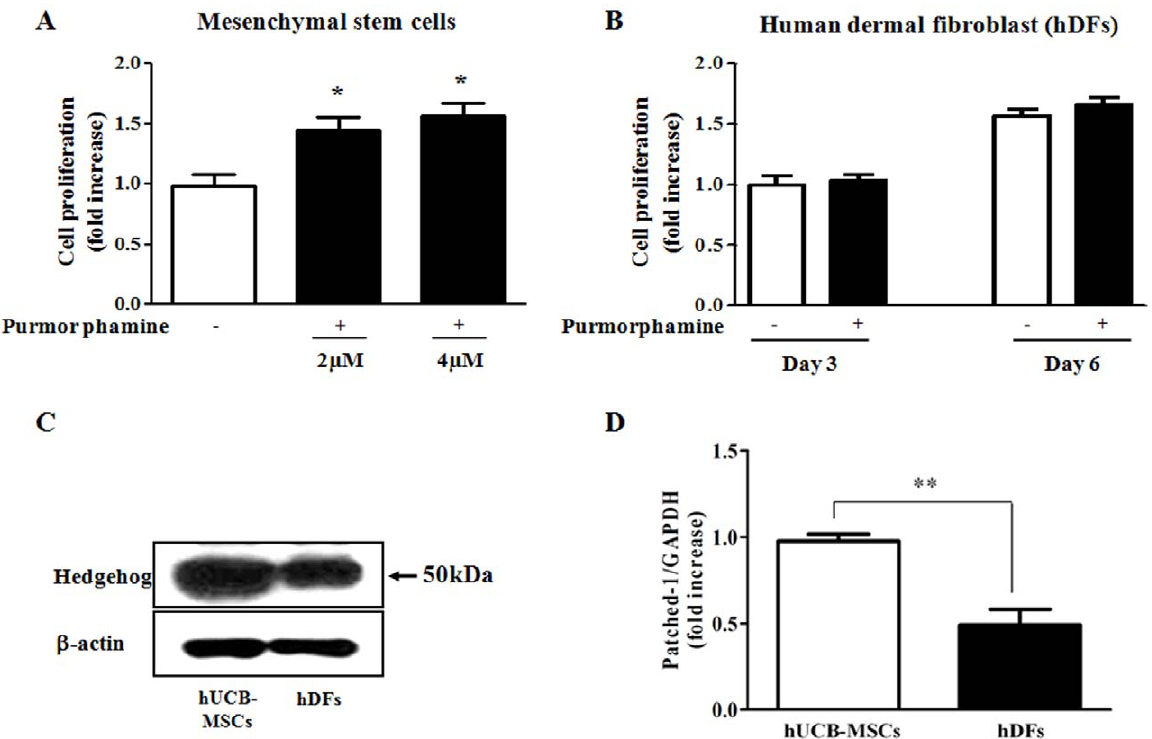
Figure 1. The Hedgehog agonist purmorphamine specifically promotes the proliferation of MSCs. hUCB-MSCs and hDFs were incubated in standard culture medium with or without purmorphamine (4 m M). Cell numbers were then obtained by direct cell counting with a hemocytometer. ( A ) Purmorphamine exposure significantly increased MSC proliferation in a dose-dependent manner compared to negative controls. ( B ) Purmorphamine treatment did not affect cell proliferation in hDFs compared to negative controls. ( C, D ) After preculture for 24 h, protein and mRNA were isolated from human dermal fibroblasts (hDFs) and hUCB-MSCs. The level of Hh expression was assessed by western blotting, and Patched-1 mRNA levels were assessed by real-time PCR. The relative expression levels of Hh and Patched-1 in hUCB-MSCs were higher than the levels observed in hDFs. b -actin was used as an internal control. The results are shown as the mean 6 SD from three independent experiments. * P , 0.05, ** P , 0.01, and *** P ,